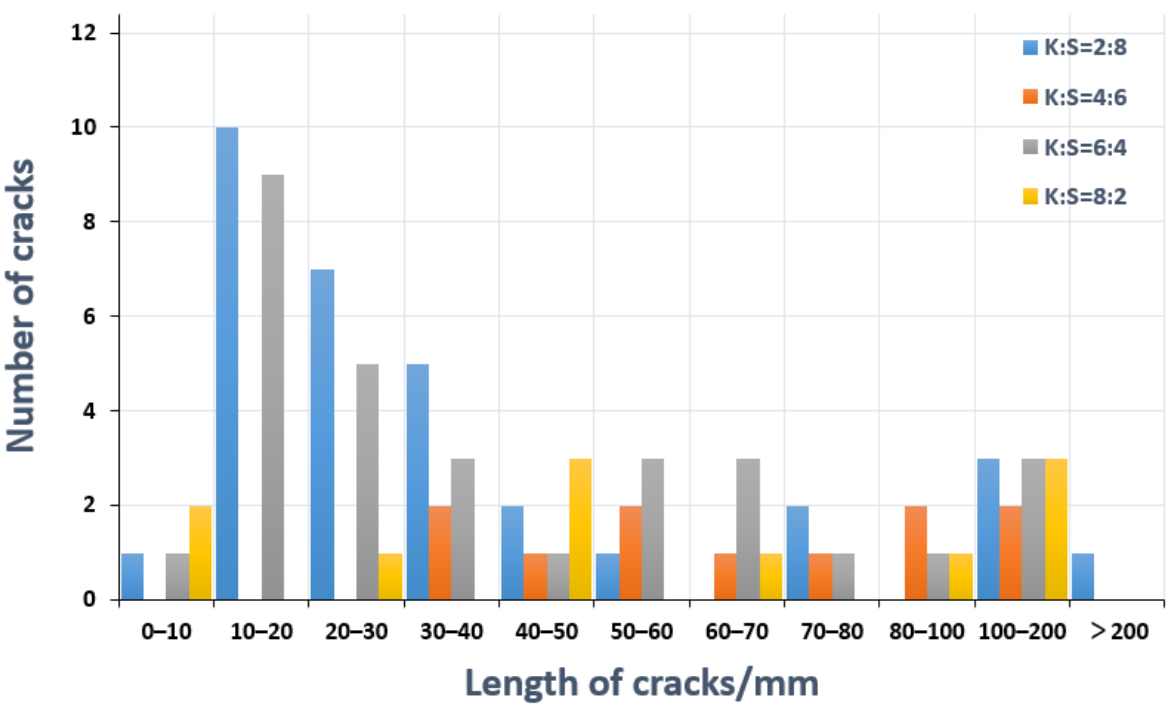
Figure 8. Desiccation crack morphology under different K:S (K:S refers to the ratio of kaolin to smectite minerals) conditions. In the figure, from left to right are S1, S5, S6, and S7, respectively. ( a ) 20% kaolin, 80% smectite. ( b ) 40% kaolin, 60% smectite. ( c ) 60% kaolin, 40% smectite. ( d ) 80% kaolin, 20% smectite. (The diameter of the sample is 24 cm).